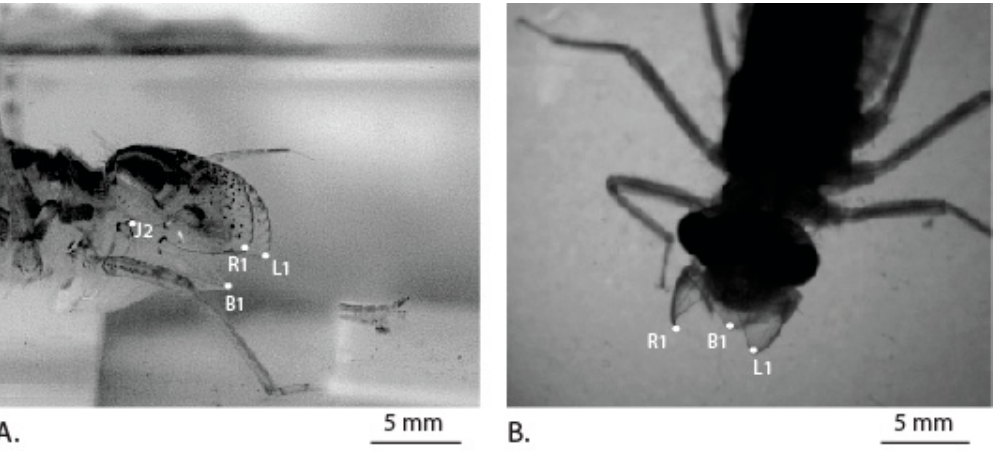
Figure 5. Position of palpi just before protraction of the labium. ( A ) Side view. ( B ) Top view.